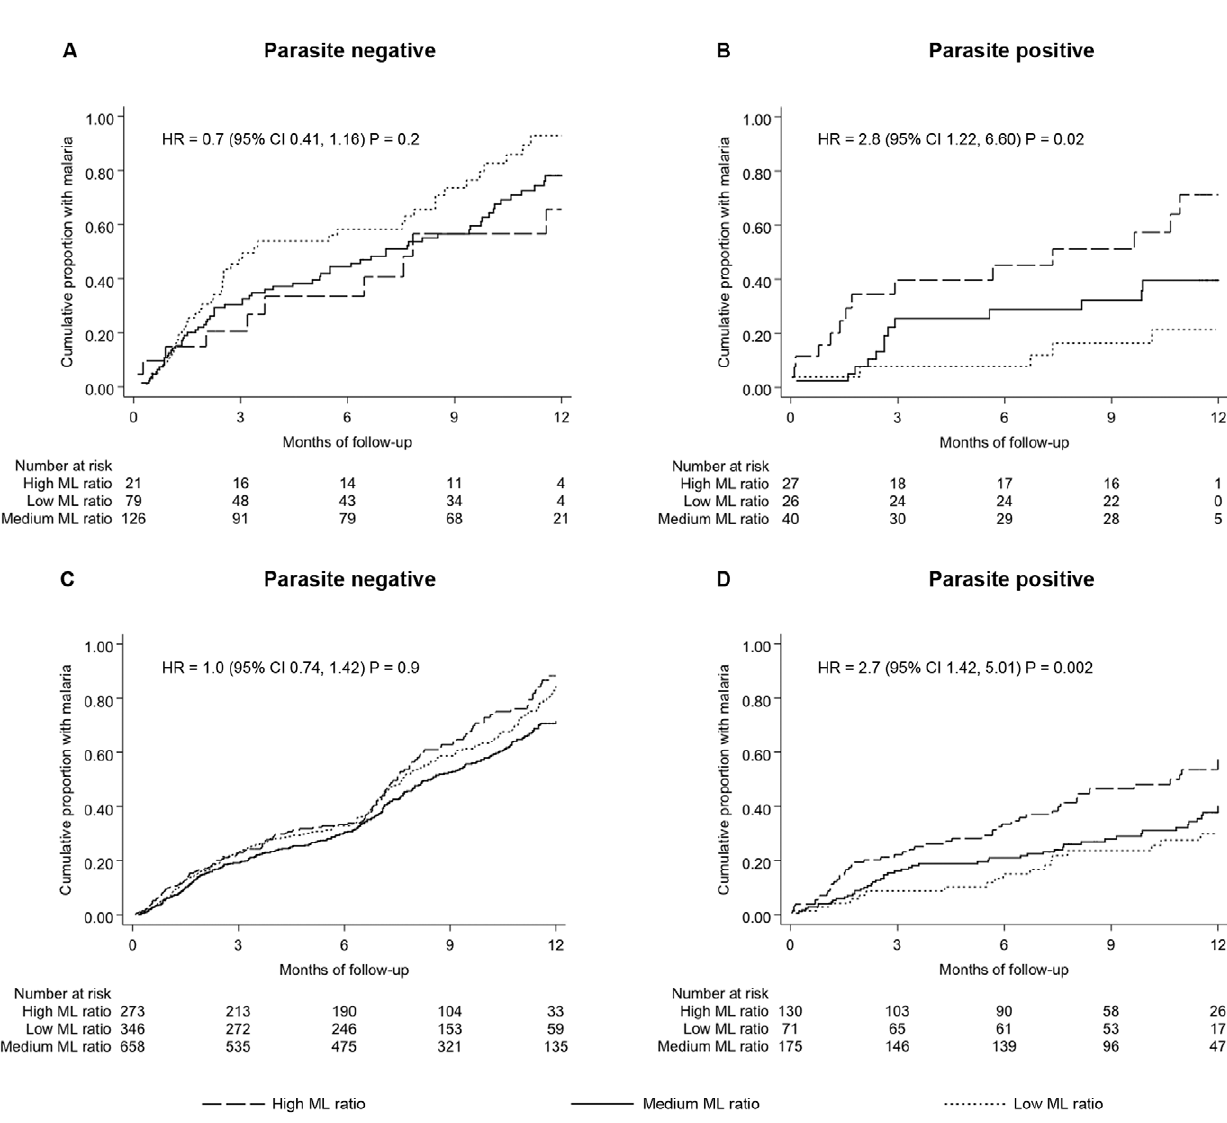
Figure 1. ML ratio positively correlates with risk of clinical malaria. Kaplan-Meier plots of the relationship between ML ratio and time to first episode of clinical malaria during follow-up is shown. (A) and (B) represent results using ML ratios measured in the May 2008 baseline survey and consider a follow-up period ending on 31 st December 2011. However, most parasite positive children had experienced their first clinical malaria episode within a year since sampling in the May 2008 baseline survey and so the plots show data for the first 12 months of follow-up. (C) and (D) represent results based on ML ratios measured at each of five surveys (May 2007, 2008, 2009, 2010 and 2011) and consider time to the first episode within the respective one year inter-survey periods as the primary endpoint. The hazard ratios (HR) from unadjusted Cox regression models using ML ratio as the only explanatory variable are shown. The cumulative proportion of children with malaria in relation to their ML ratio, stratified into three arbitrary groups, is shown. ‘‘High ML ratio’’ and ‘‘Low ML ratio’’ represent children whose ML ratio falls in the top and bottom 25 th percentile of the sampled population, respectively, whilst ‘‘Medium ML ratio’’ represents all other children. However, a positive correlation of ML ratios between different surveys was only observed consistently when comparisons were made between parasite negative children (Fig. 2) suggesting that ML ratios are stable over time but only in the absence of P.